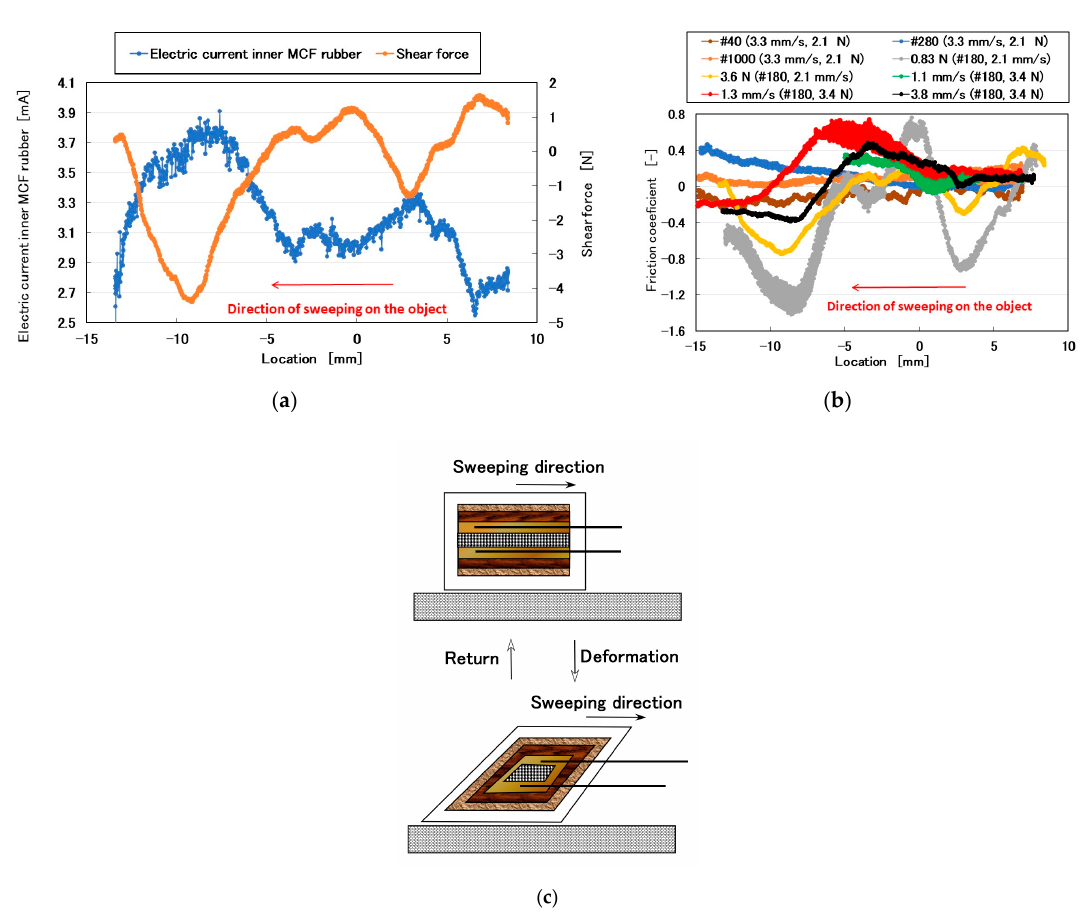
Figure 3. Electrical properties of MCF rubber sensor rubbing over sandpaper in the SFE: the force is presented as the initial normal force just before sweeping. The sweeping velocity is also presented.